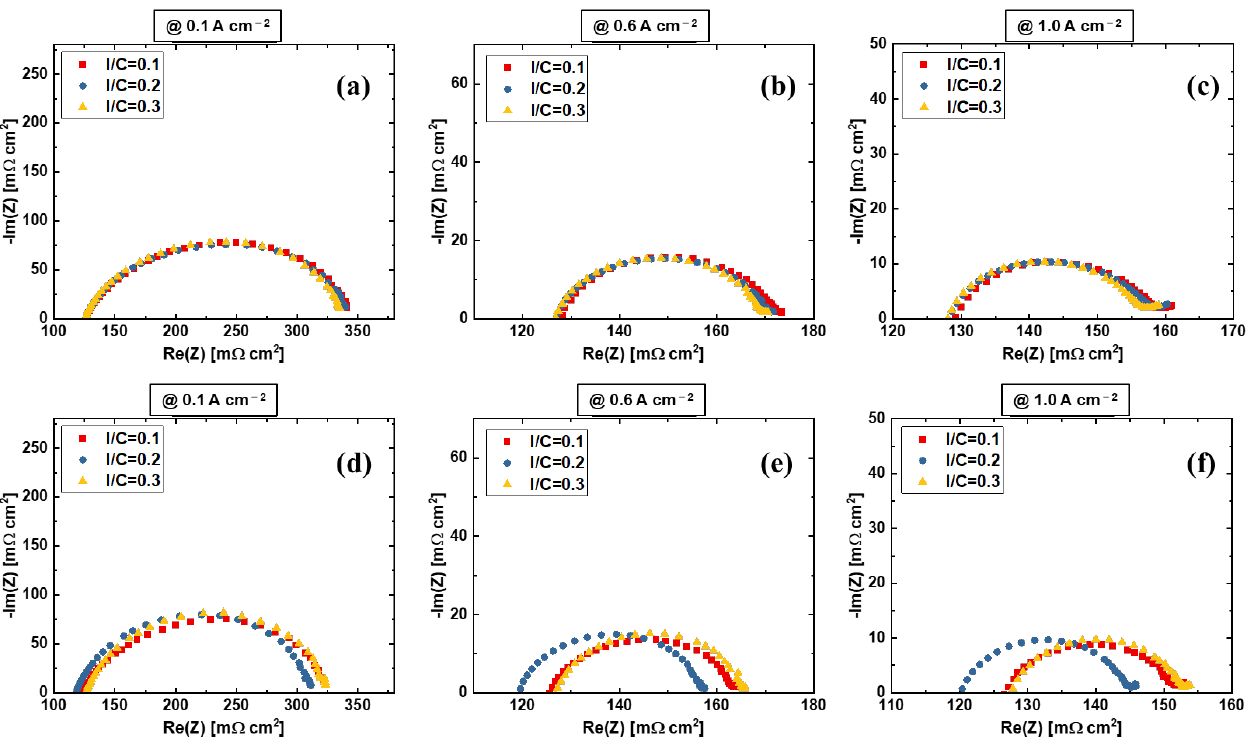
Figure 7. EIS comparison at ( a , d ) 0.1 A cm −2 , ( b , e ) 0.6 A cm −2 , and ( c , f ) 1.0 A cm −2 with two fabrication methods: ( a – c ) rod coating and decal transfer, and ( d – f ) blade coating and decal transfer.